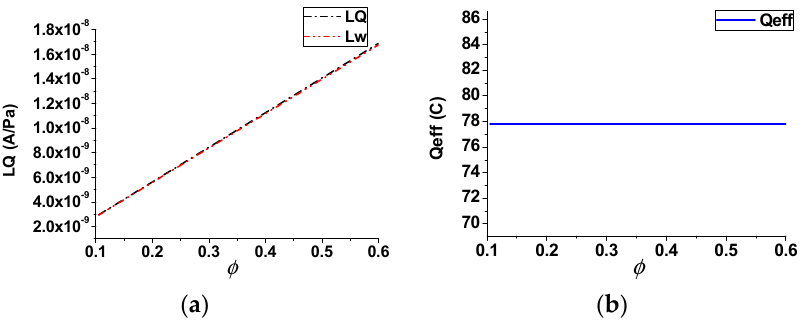
Figure 9. Effect of the porosity (time-harmonic case): ( a ) streaming current coupling coefficient; ( b ) effective net residual charge density.